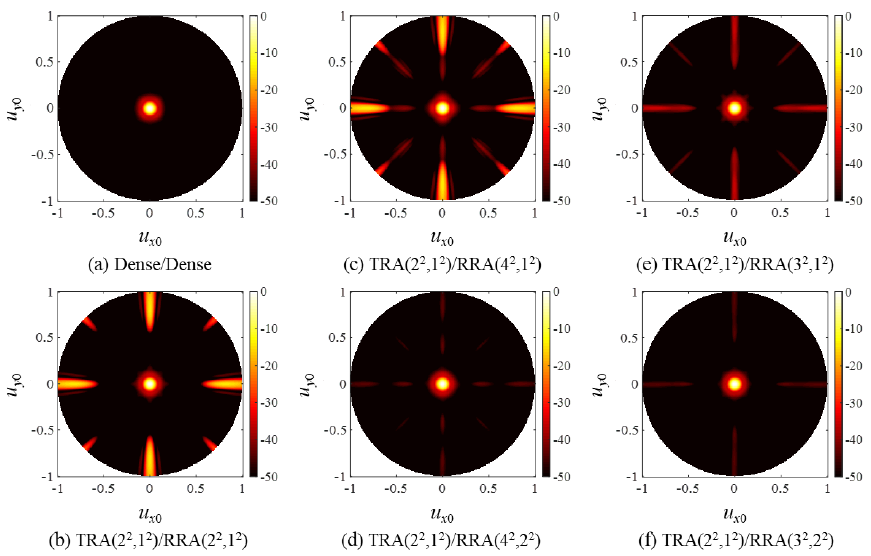
Figure 8. Two-way, pulsed wave (PW) PSFs of ( a ) the dense array pair and ( b – f ) the SRA pairs.